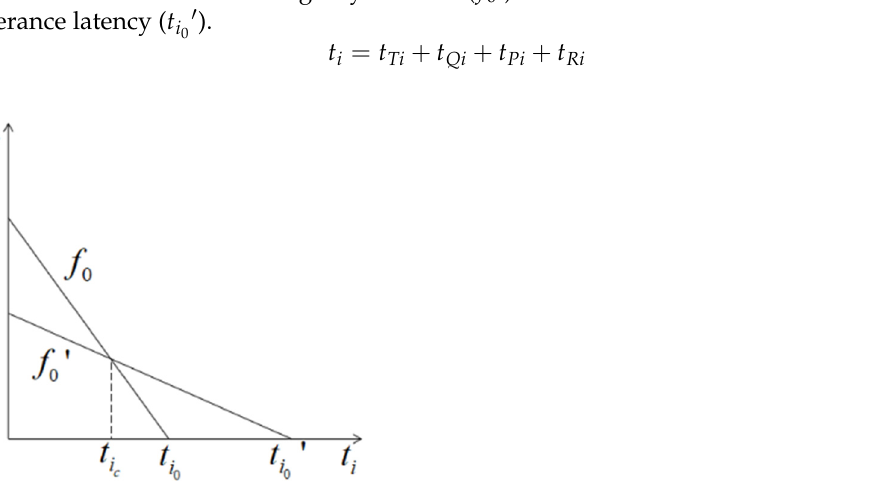
Figure 3. The relationship between reward function and latency.